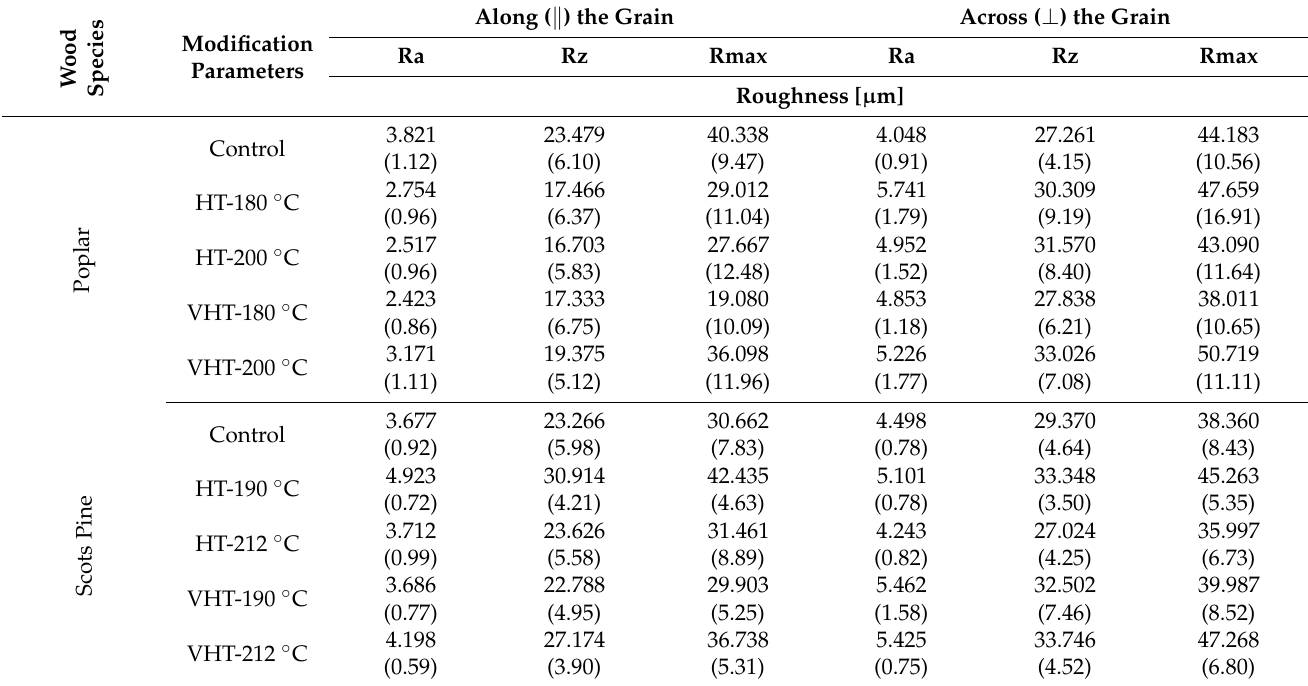
Table 1. Average surface roughness values of poplar and Scots pine after heat (HT) and vacuum heat (VHT) treatment.